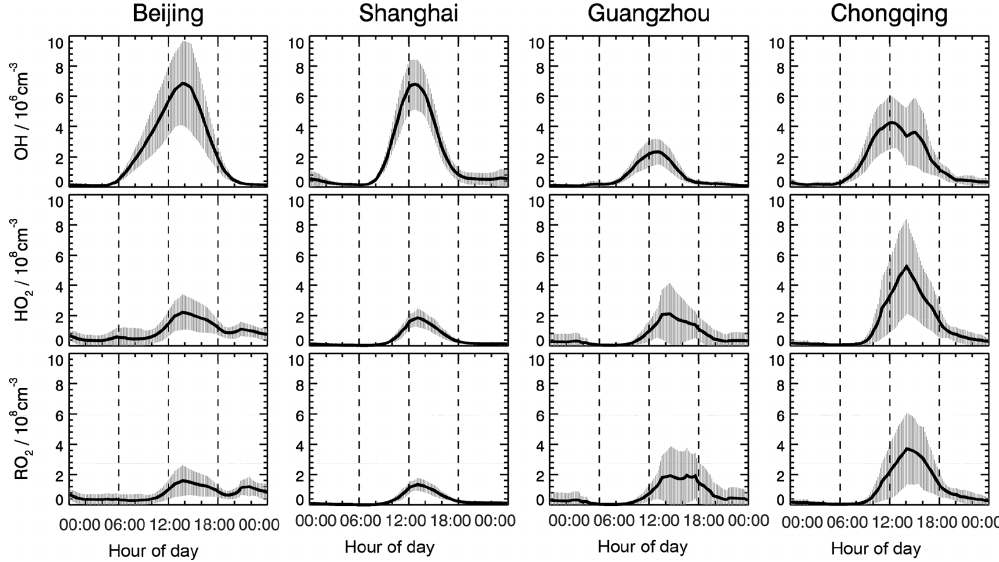
Figure 5. Mean diurnal profiles of the OH, HO 2 , and RO 2 concentrations modeled for the four measurement sites. The vertical bars denote the daily variability of the model-calculated radical concentrations.